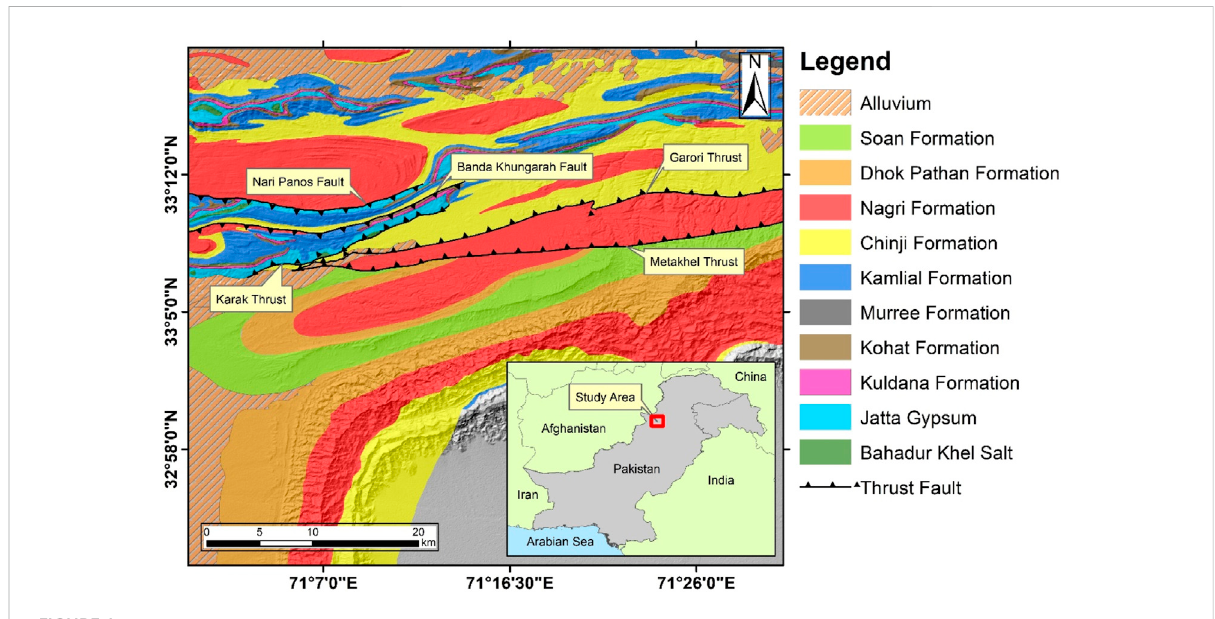
FIGURE 1 Geological map of the study area (redrawn after Meissner et al.